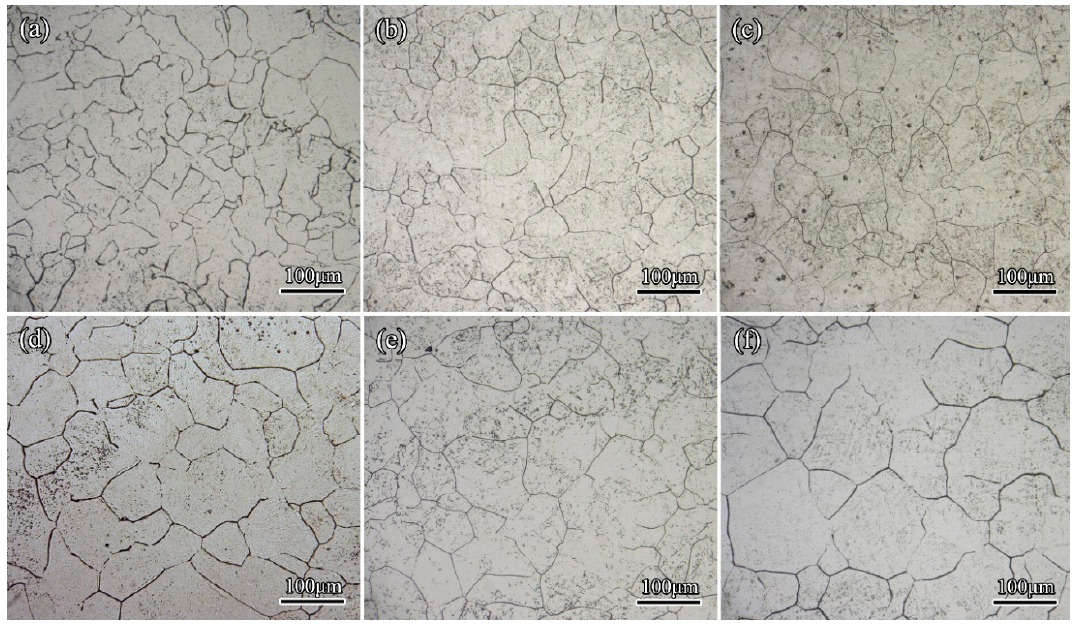
Figure 8. The ex-situ observed microstructures of 300M steel after holdings at ( a ) 900 °C; ( b ) 950 °C; ( c ) 1000 °C; ( d ) 1050 °C; ( e ) 1100 °C; and ( f ) 1150 °C for 1200 s. The average grain sizes were 28, 42, 46, 66, 73, and 81 μ m, respectively.